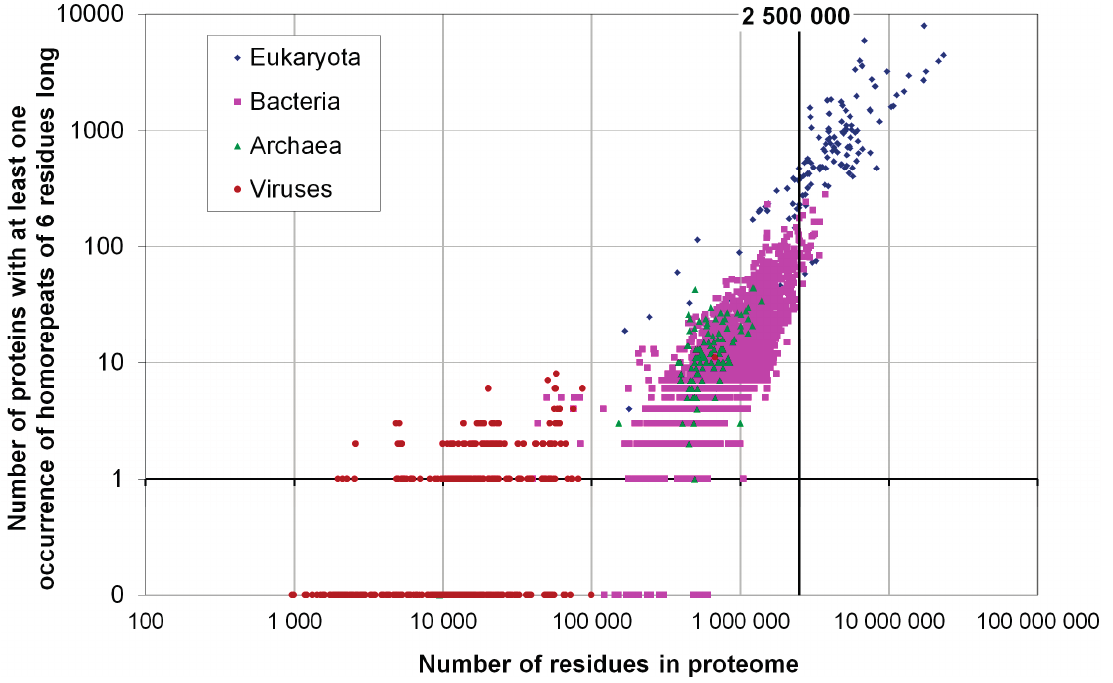
Figure 1. Number of proteins with at least one occurrence of homo-repeat of 6 residues long for 1902 proteomes from eukaryotes (137), bacteria (1540), archaea (105) and viruses